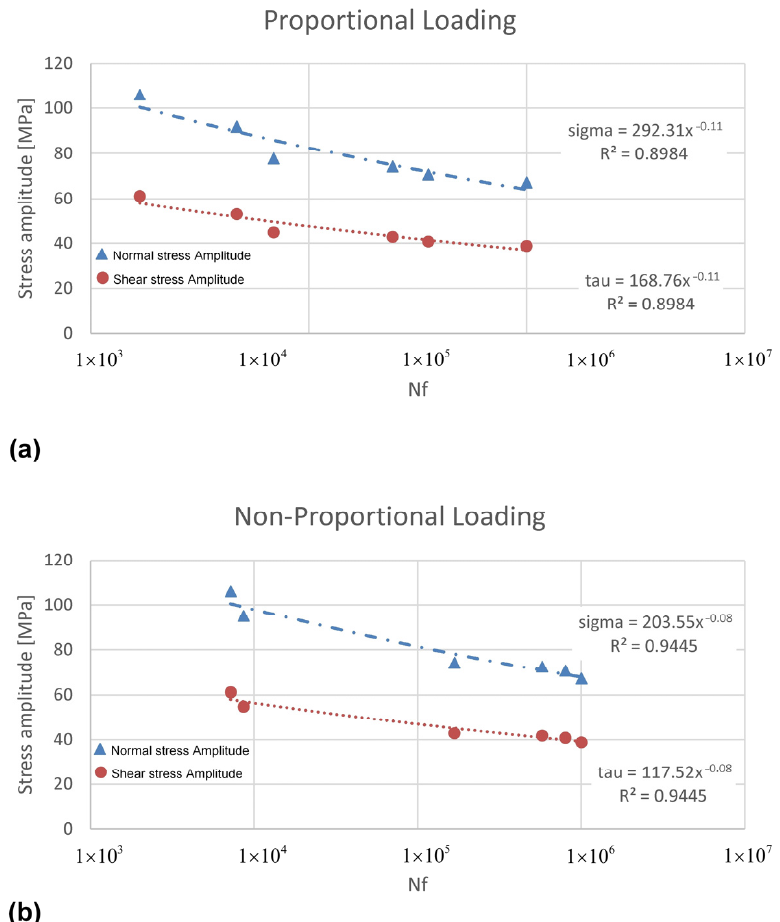
Figure 3. ( a ) Proportional loading results and respective SN trend lines, ( b ) non-proportional fatigue strength and respective SN trend lines.